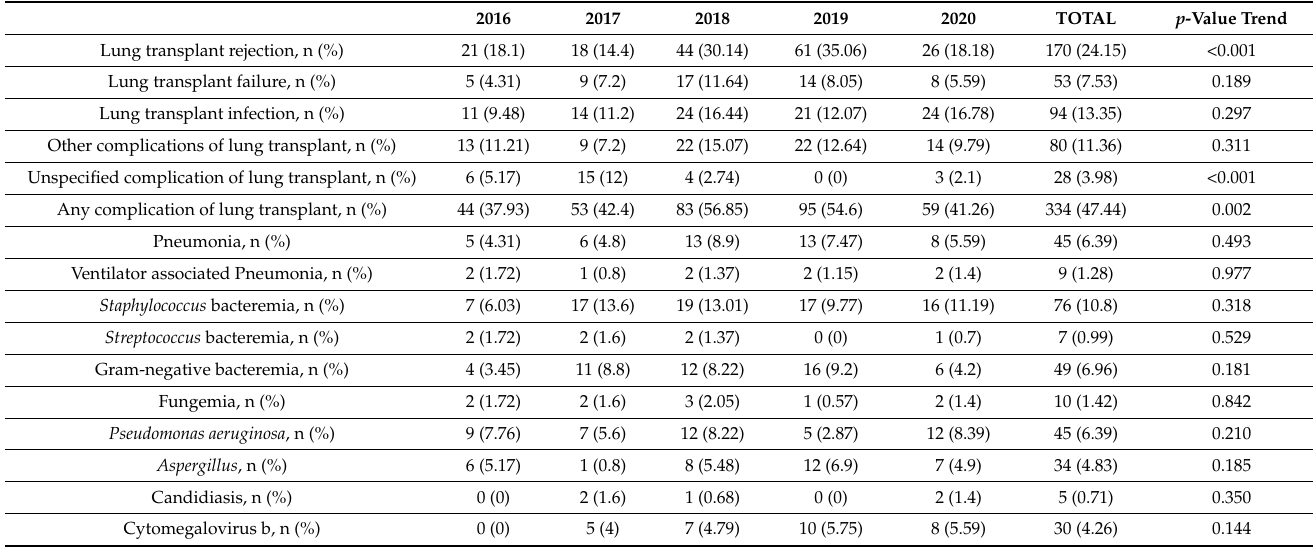
Table 3. Complications and pathogen isolations on hospitalized patients with COPD who underwent lung transplantation in Spain from 2016 to 2020.